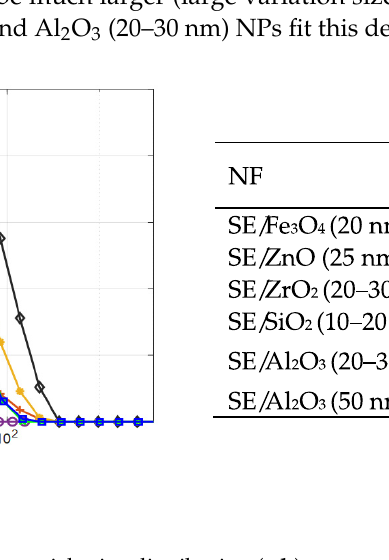
Table 3. Zeta potential and electrical conductivity of nanofluids samples.